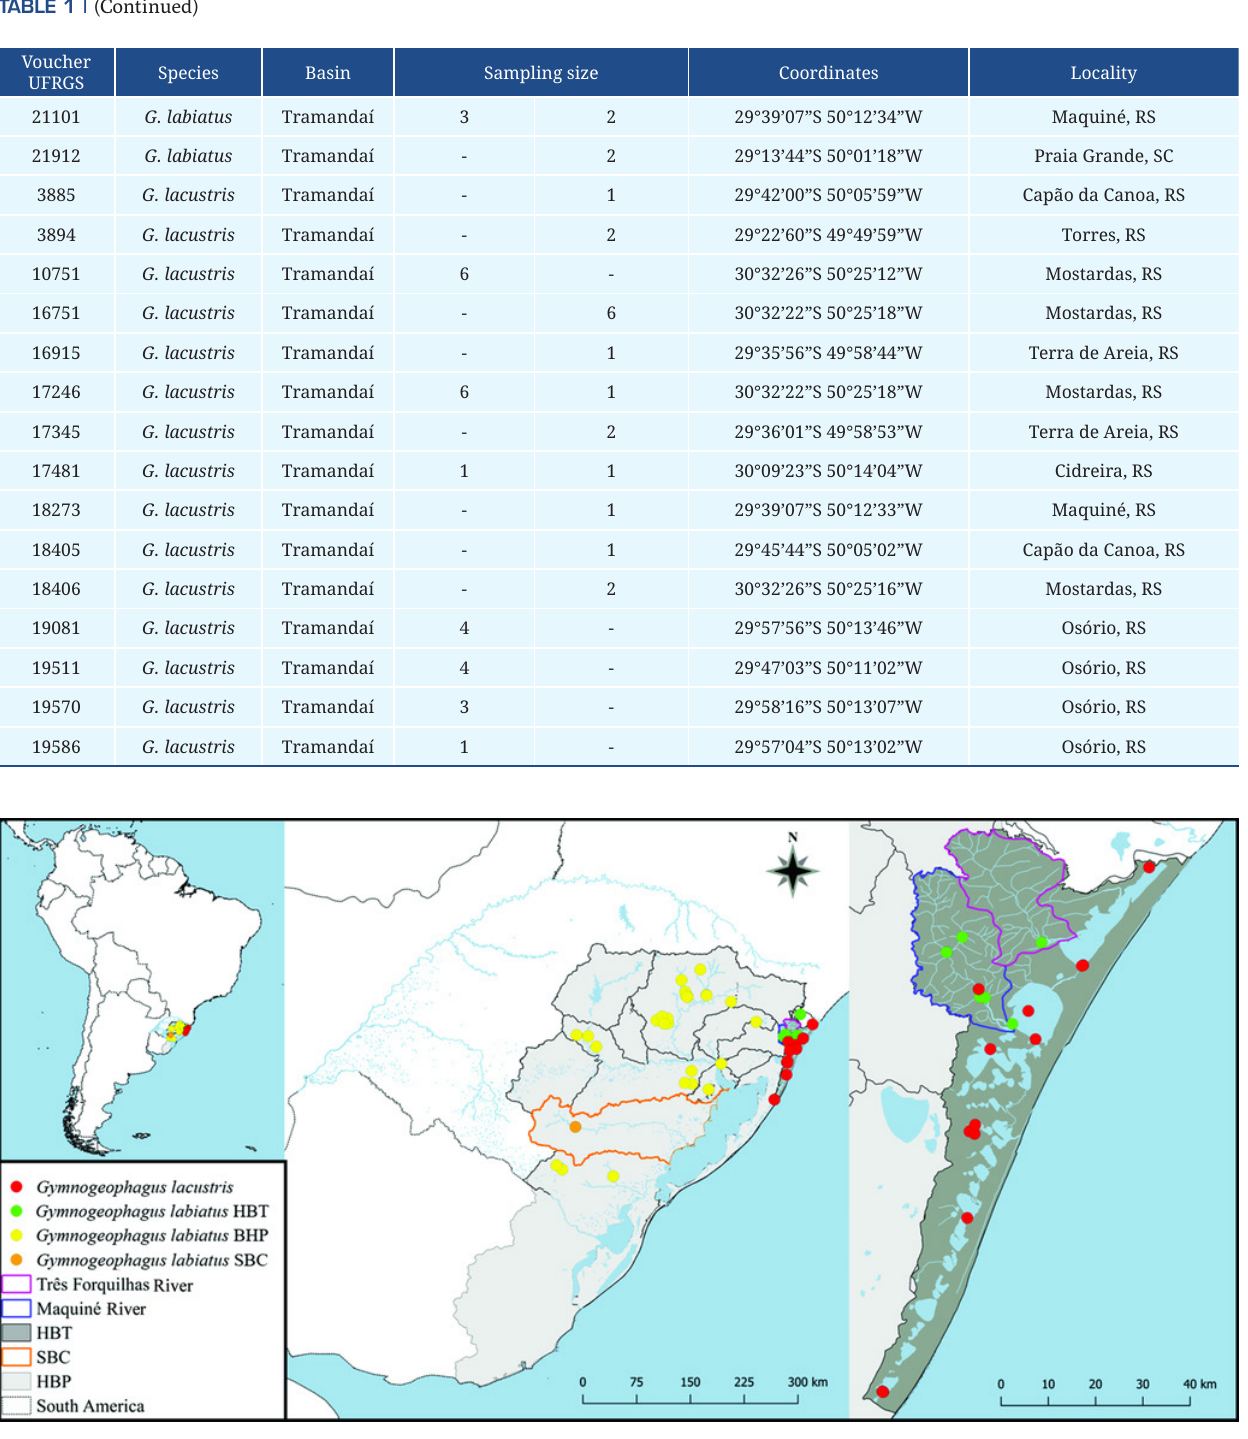
FIGURE 1 | Map with the distribution of all individuals used in the present study. The hydrographic basins of the Patos Lagoon (HBP) and the Tramandaí River (HBT), as well as the Camaquã Sub-Basin (CSB), are indicated on the map. The gray lines represent the watershed between basins or sub-basins in the study area. The red dots correspond to Gymnogeophagus lacustris , the green to G. labiatus HBT, the yellow to G. labiatus HBP and the orange to G. labiatus